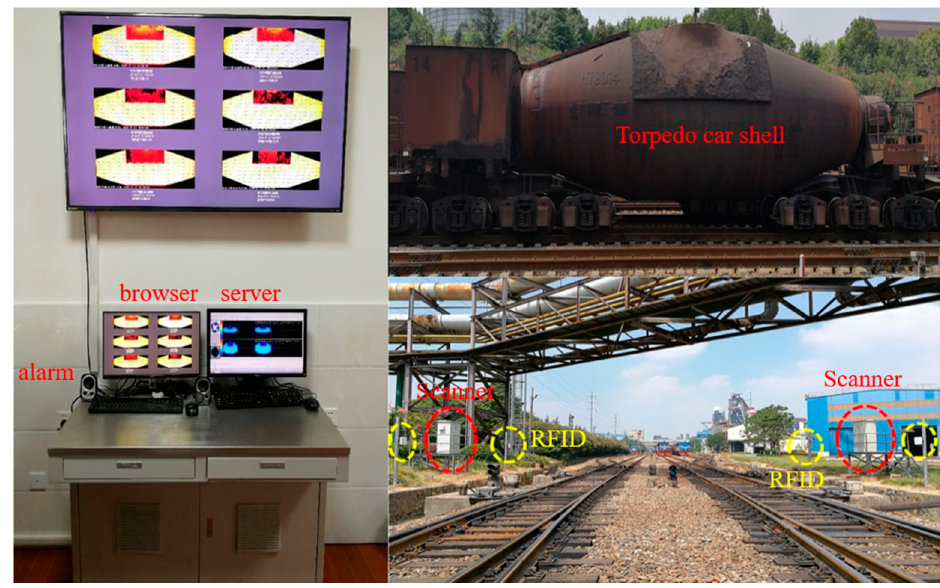
Figure 5. Online monitoring application.